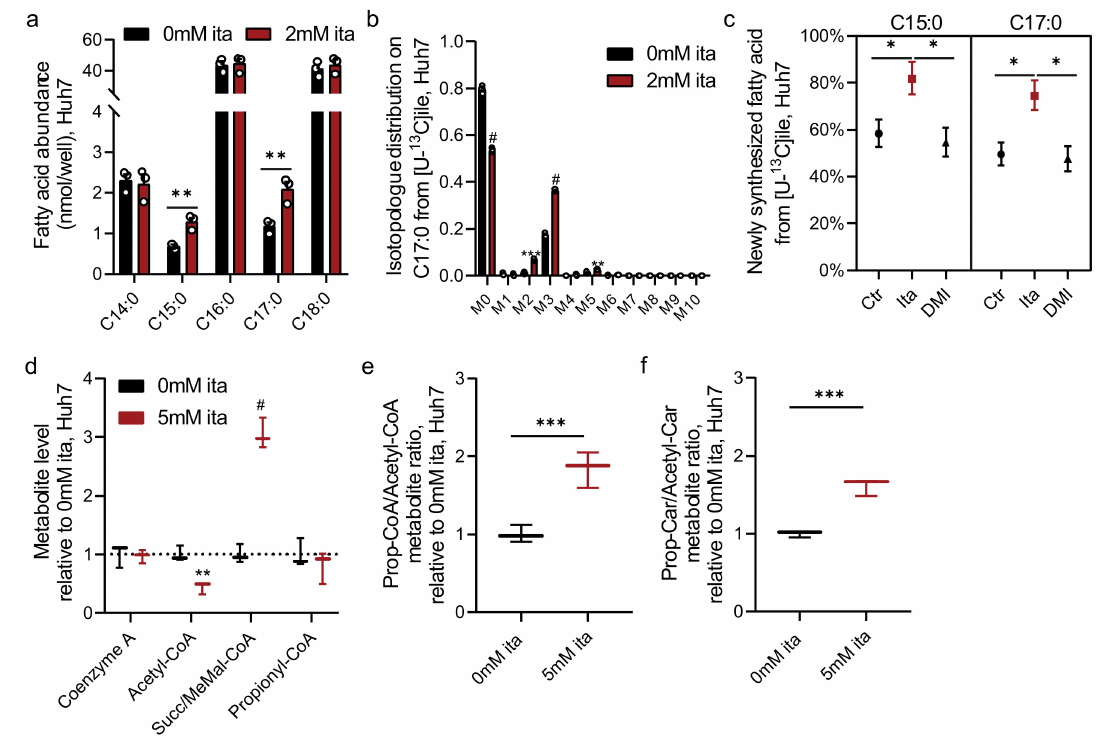
Figure 5. Itaconate alters fatty acid diversity and CoA metabolism. ( a ) Levels of fatty acids in Huh7 cells cultured for 48 h in the presence of 2 mM ita. ( b ) Isotopologue distribution on C17:0 from [U- 13 C 6 ]isoleucine in Huh7 cells after 48 h. ( c ) Newly synthesized C15:0 and C17:0 from [U- 13 C 6 ]isoleucine in Huh7 cells exposed to itaconate or dimethyl-itaconate (DMI) for 48 h. ( d ) Levels of CoA species in Huh7 cells exposed to 5 mM itaconate for 48 h compared to 0 mM itaconate (dotted line). MeMal-CoA; Methylmalonyl-CoA. ( e ) Propionyl-CoA to acetyl-CoA metabolite ratio in Huh7 cells after 48 h. ( f ) Propionyl-carnitine to acetyl-carnitine metabolite ratio in Huh7 cells after 48 h. Data are depicted as box and whiskers ( d – f ), mean ± s.e.m. ( a,b ) or 95% confidence intervals from ISA model ( c ) obtained from 3 cellular replicates. Students t -test ( a , b , d – f ) with no adjustment for multiple comparisons * p < 0.05, ** p < 0.01, *** p < 0.001, # p < 0.0001. Significance was considered as non-overlapping confidence intervals for ( c